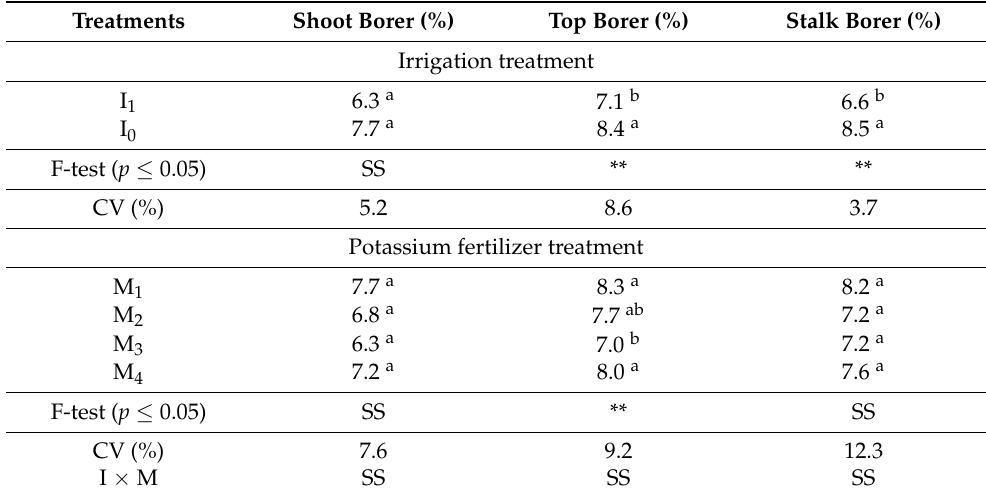
F-test ( p ≤ 0.05) SS ** CV